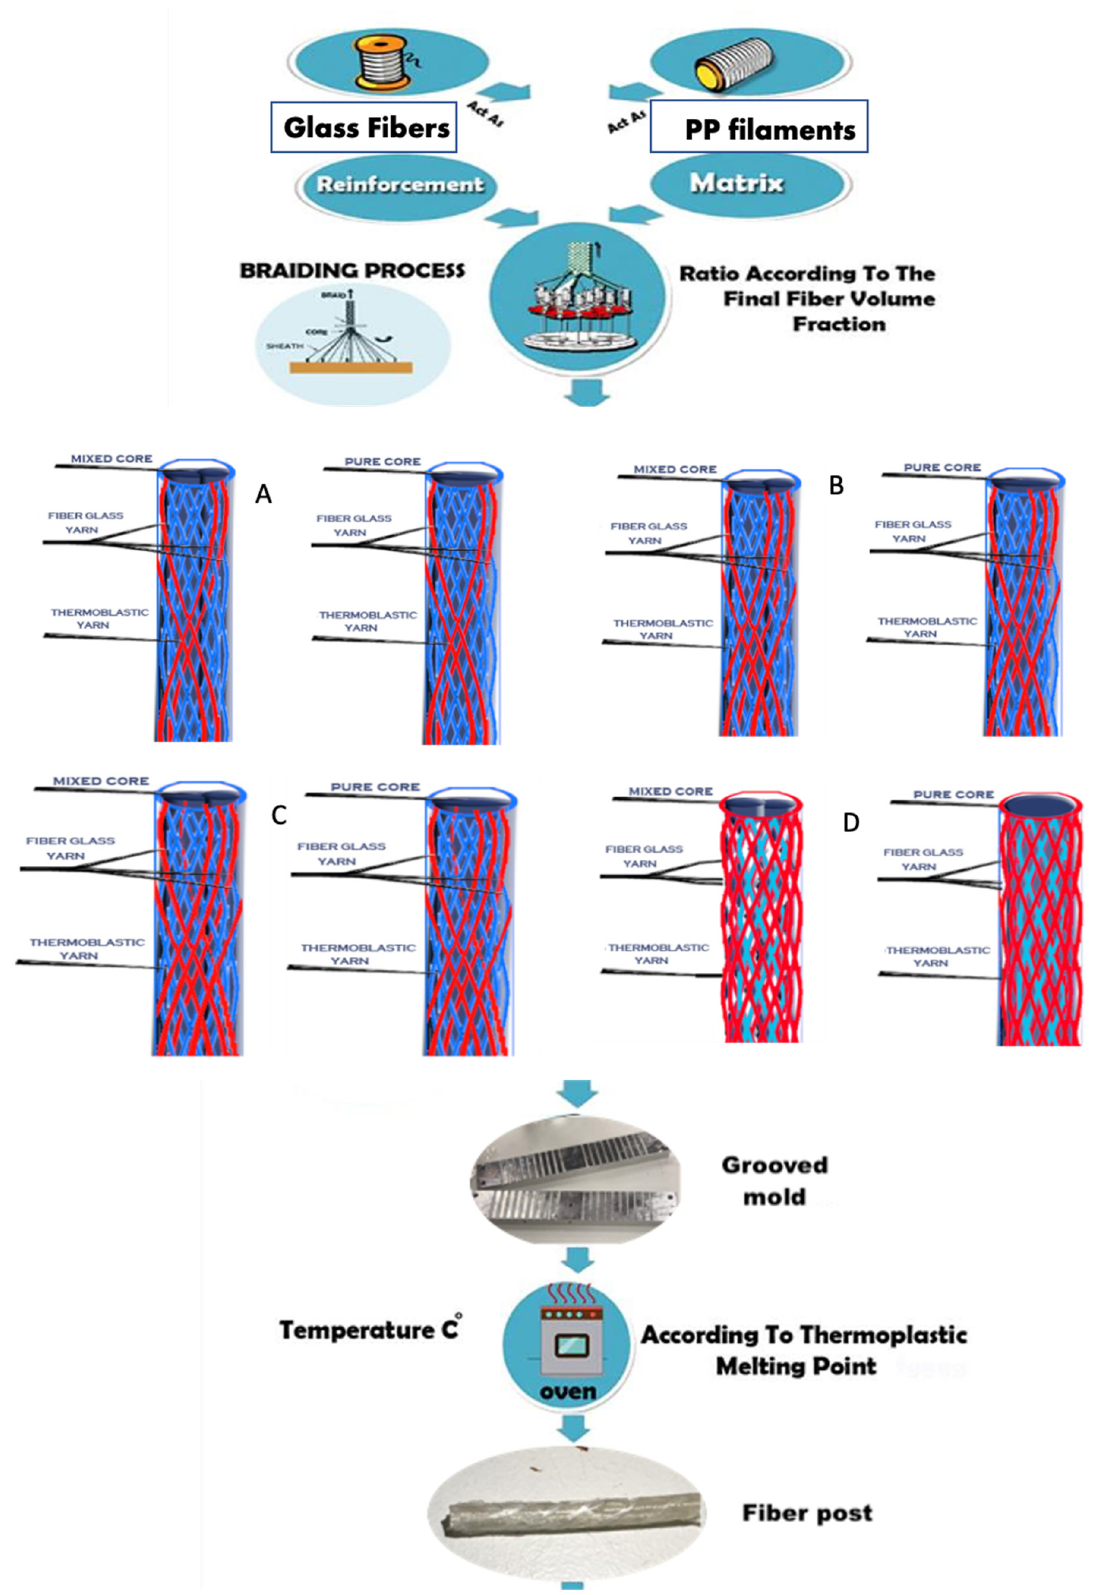
Figure 1. Schematic representation for the steps of experimental post production, ( A – D ) represent different core construction (mixed and pure) and the different sheath composition with increase in GF% (red lines) in relation to PP fibers % (blue lines) from ( A – D ).